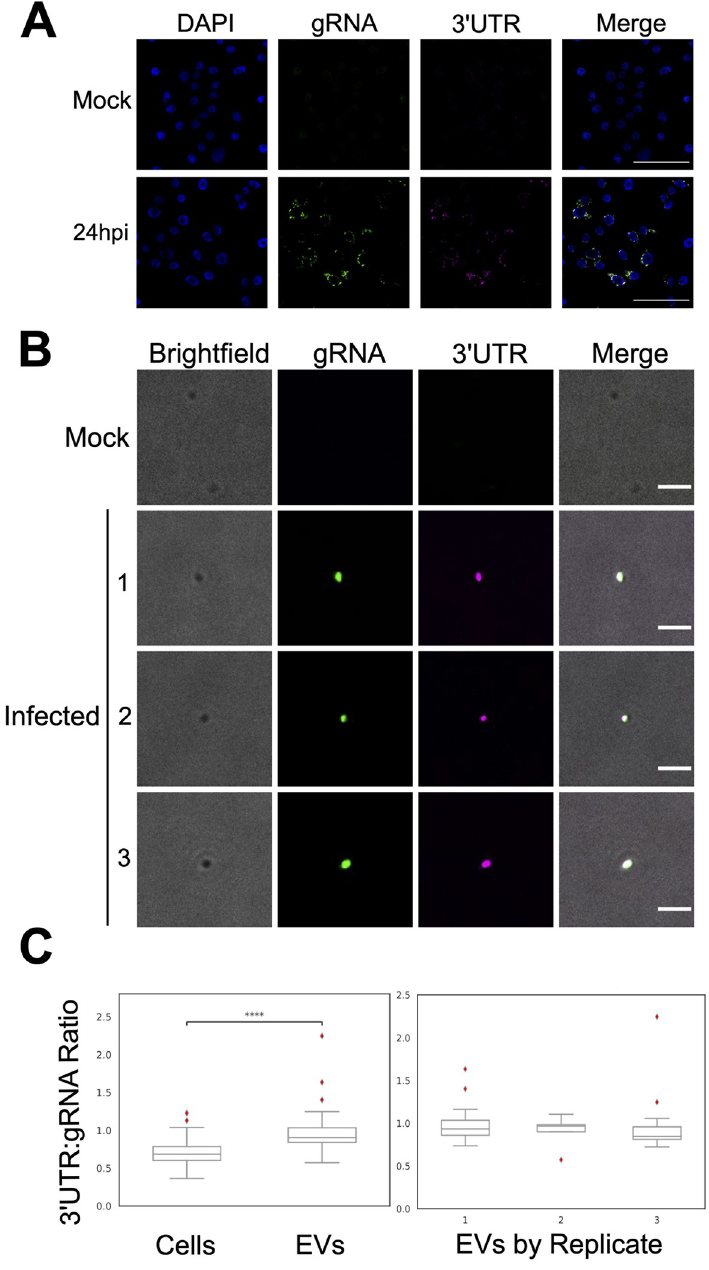
Fig 3. Mosquito salivary EVs are enriched in DENV2 3’UTR RNA, relative to infected cells. (A) Representative images of nuclei (blue), DENV2 gRNA (green), and DENV2 3’UTR (magenta) from C6/36 cells 24 h.p.i. with DENV2 NGC at an MOI of 0.3. Scale bar, 50 μ m. (B) Representative images of EVs imaged in brightfield (grey), DENV2 gRNA (green), and DENV2 3’UTR (magenta) from Ae . aegypti saliva collected 10 days post inoculation with DENV2 NGC. Scale bar, 2 μ m. ( A & B ) RNA-FISH of DENV2 gRNA and 3’UTR labelled with Oligopaints probes. (C) Ratios of DENV2 3’UTR: gRNA fluorescence signals as detected via RNA-FISH in DENV2 NGC infected C6/36 cells and EVs from Ae . aegypti saliva (left). Ratios of DENV2 3’UTR: gRNA fluorescence signals as detected via RNA-FISH on EVs from Ae . aegypti saliva from the three independent labelling experiments (right). ���� , p � 10 − 4 as determined by a two-sided Mann-Whitney U test. Exact p-value = 1.79 x 10 − 12 . N Cells = 102; N EVs = 35.